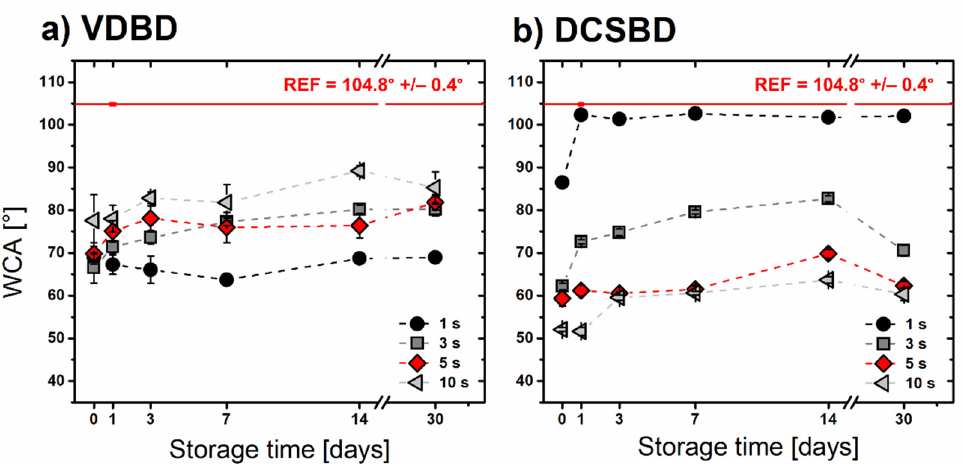
Figure 5. WCA development during the storage of BOPP foils under laboratory conditions: WCA values dependent on storage time after the plasma treatment by ( a ) VDBD and ( b ) DCSBD.